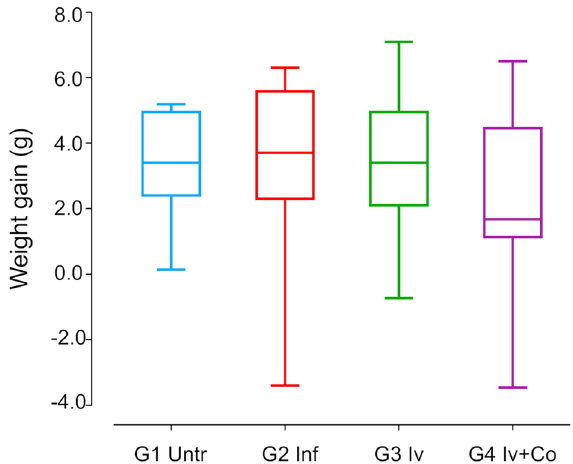
Figure 2. Weight gain throughout experimental period of eight weeks post-infection. Mice treated with ivermectin (Iv) or ivermectin and cobicistat (Iv + Co), infected with 150 cercariae of S. mansoni (inf) and control without treatment and infection (Untr).